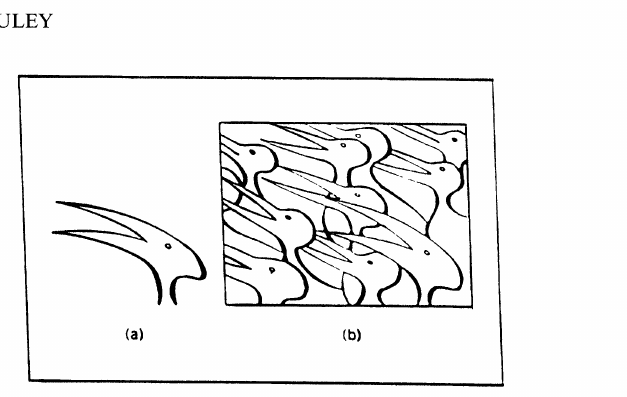
FIGURE Samuelson’s question: Is it a bird or an ante- lope? Answer: neither, it’s a continuous line between two points plus a closed curve that., unlike both birds and ante- lopes, is topologically equivalent to a straight line plus a circle (from Samuelson